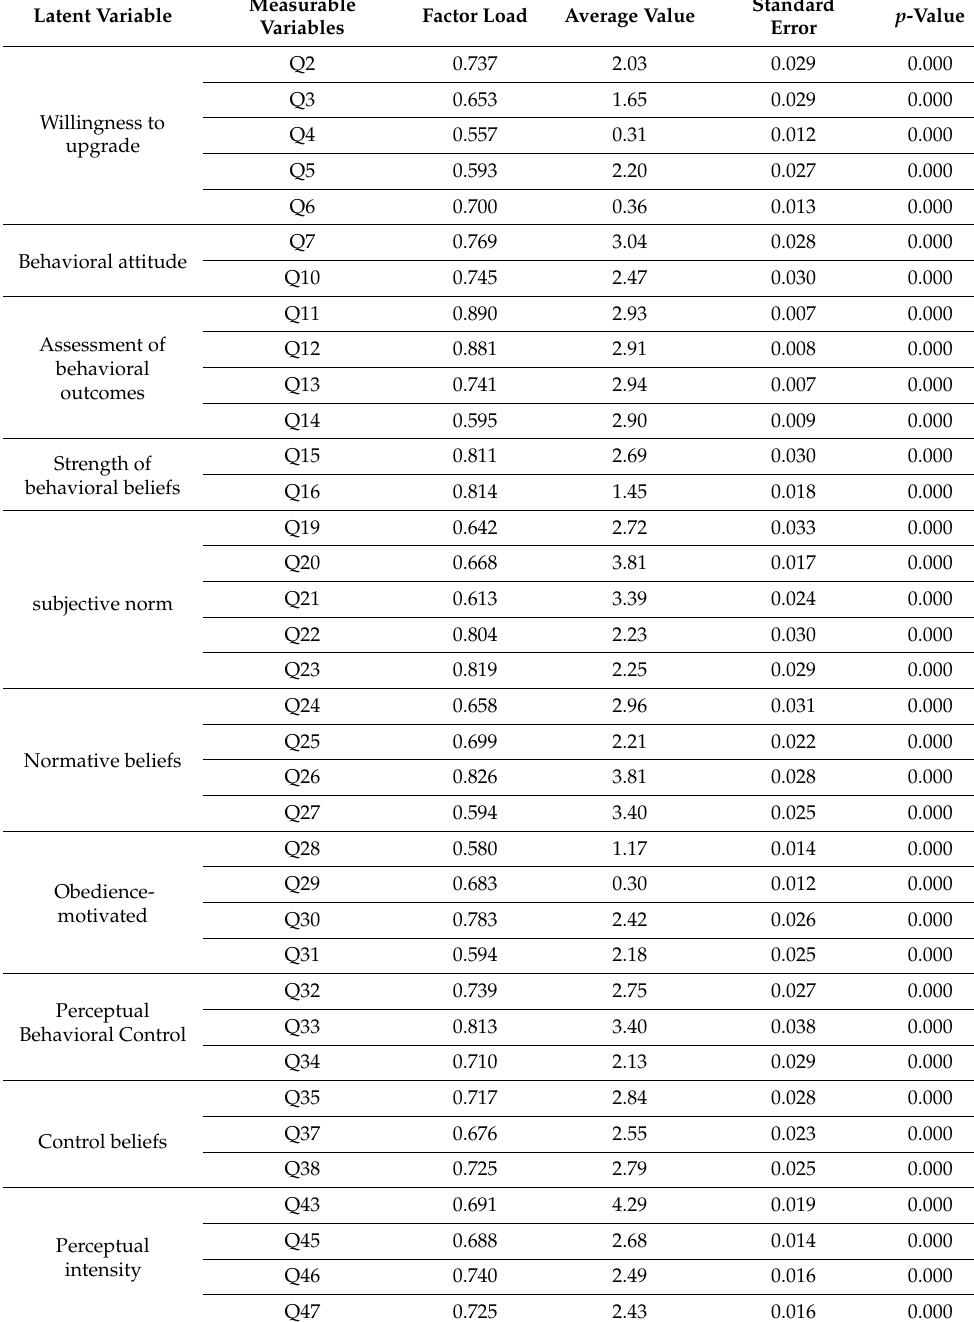
Table 3. Variable validity